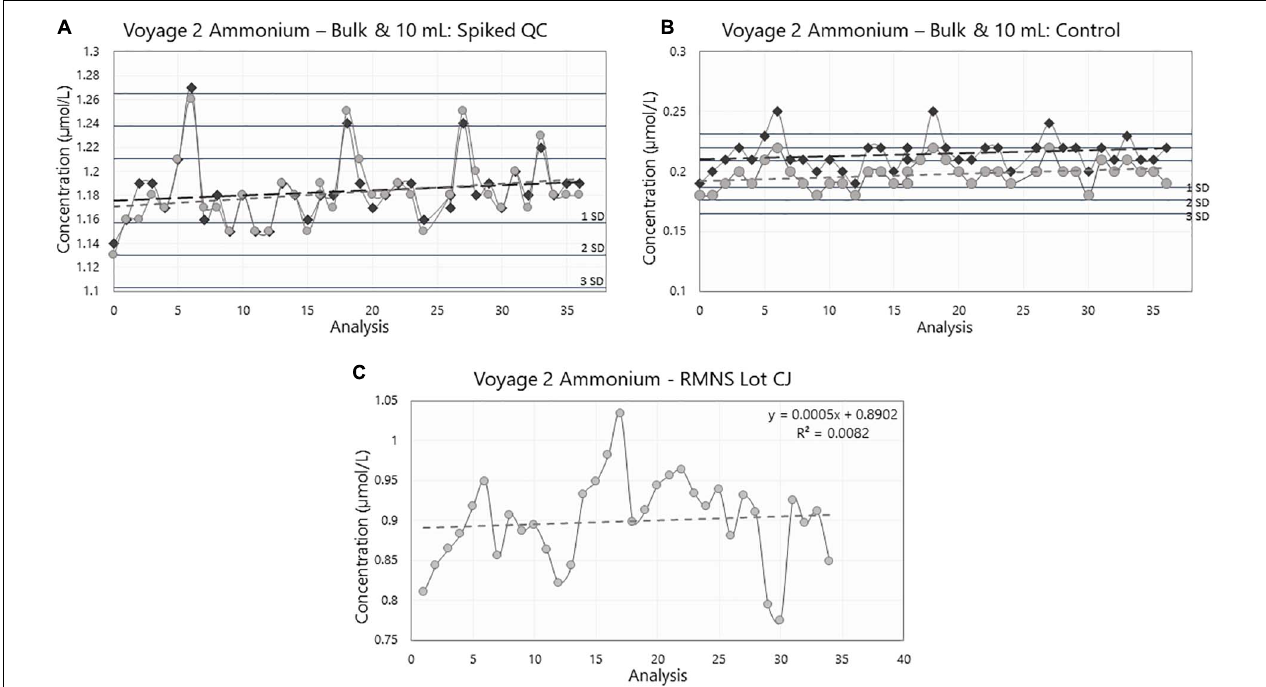
FIGURE 8 | Ammonium concentration (in µ mol/L) in (A) the bulk (dark gray) and 10 mL (light gray) Spiked QC, (B) the bulk (dark gray) and 10 mL (light gray) Control, and (C) the reference material for nutrients in seawater (RMNS) lot CJ during voyage 2 on board the RV Investigator. Horizontal lines are the standard deviation (SD) multiplied by 1, 2, and 3, centered around the mean acting as QC limits. For the charts with both the Bulk and 10 mL results, the lines are centered around the 10 mL